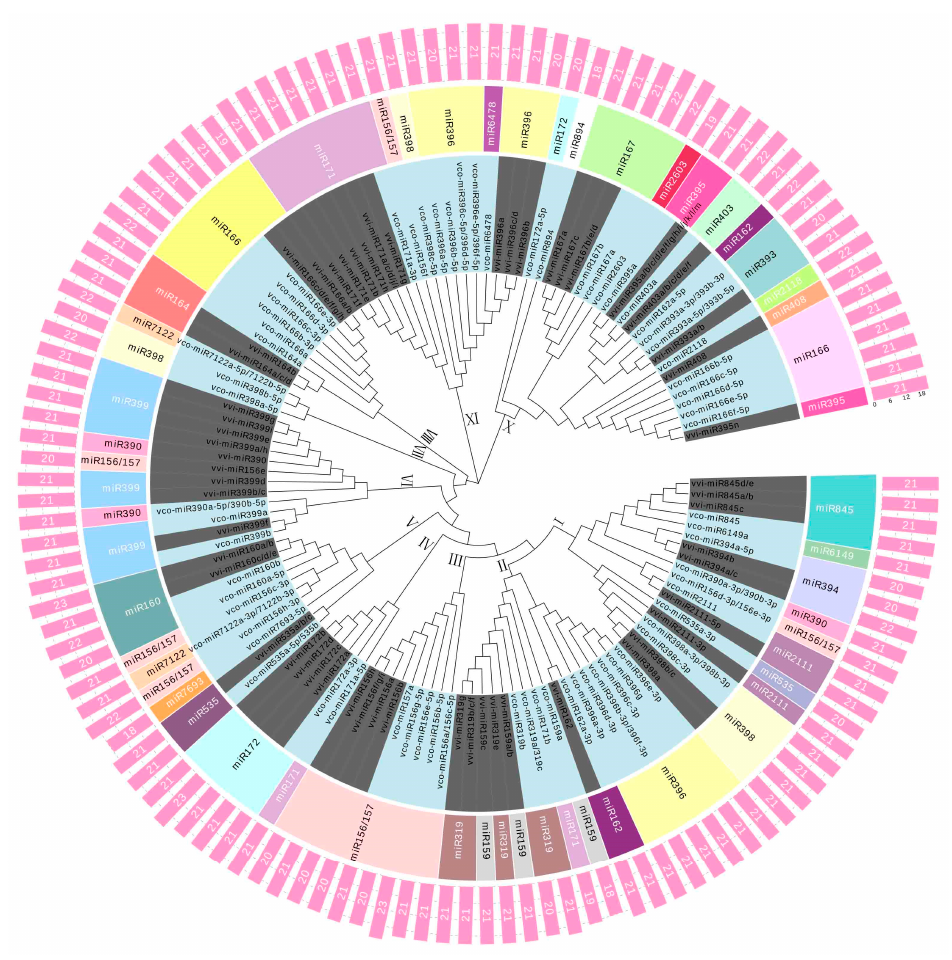
Figure 2. Phylogenetic analysis of known miRNA mature sequences of blueberry ( Vaccinium corymbosum ) and grape ( Vitis vinifera ) obtained from the sequencing data (this work) and miRbase 21.0, respectively. The miRNAs were clustered into 10 classes (I–X). The miRNAs in light blue background were from blueberry and the ones in dark grey were from grape in the inner ring. The middle ring shows the miRNA families in different colors. The outer ring shows the length of mature miRNAs.